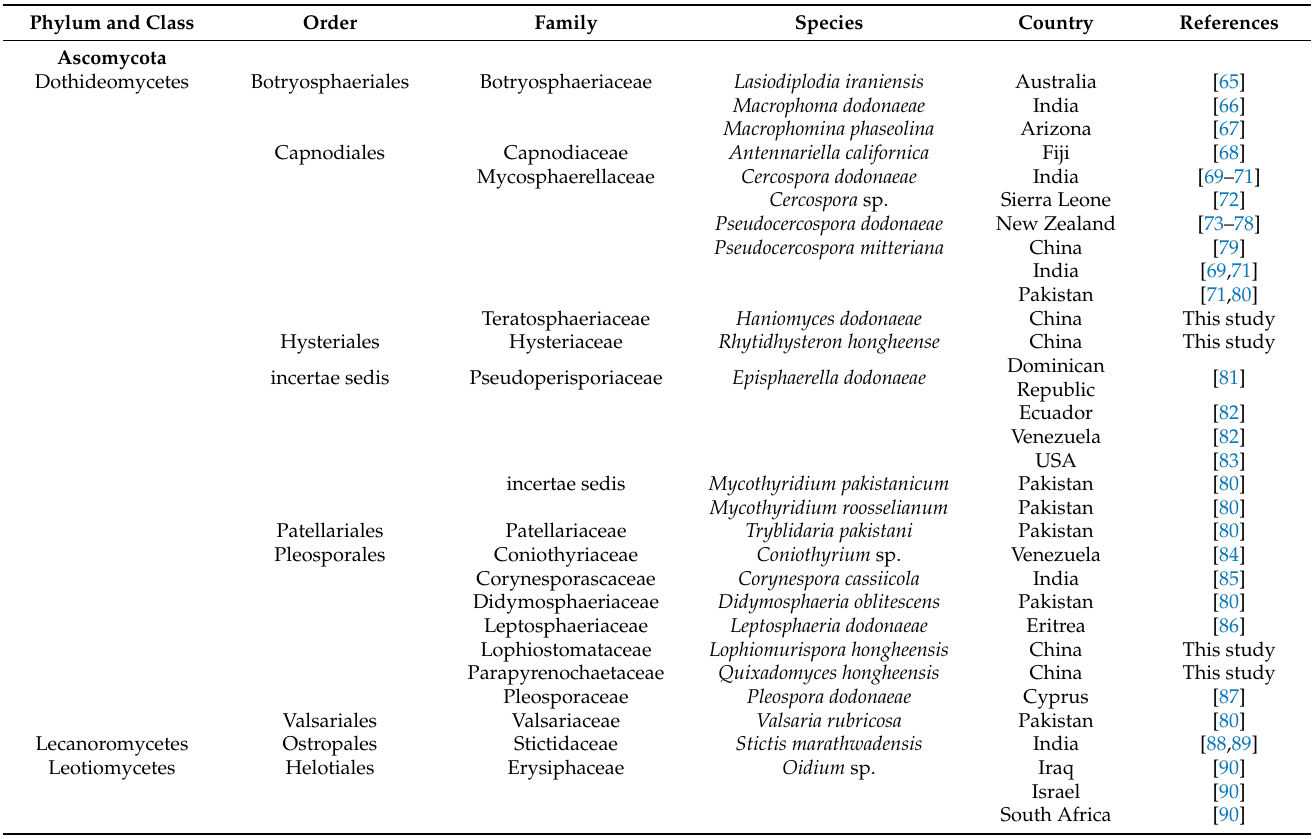
Table 2. Checklist of fungi recorded from Dodonaea viscosa in worldwide. Phylum and Class Order